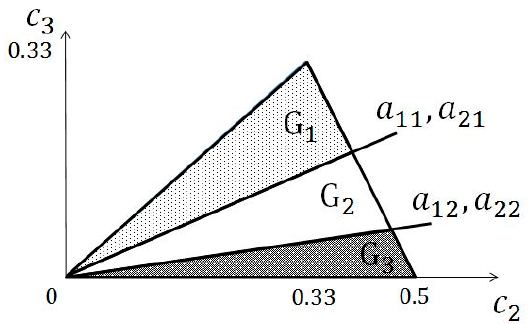
Figure 6. Classification of voxels with the shape-based index defined by Equation (3). a i 1 and a i 2 are thresholds in the i -th loop for discriminating G 1 from G 2 , and G 3 from G 2 , respectively.